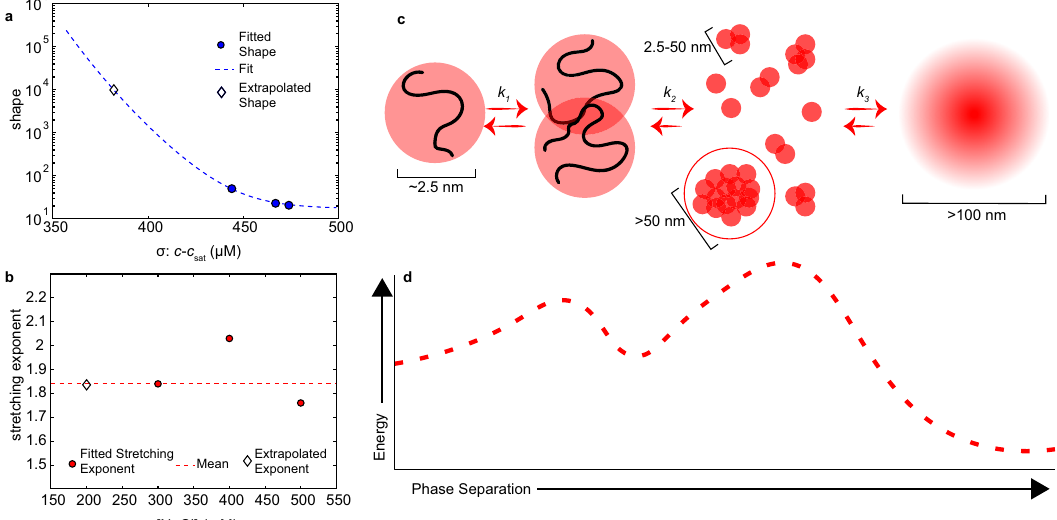
Fig. 9 Mesoscopic A1-LCD assembly is nucleated by an activated state. a The shape parameter de fi nes the Weibull distribution width, which is the timescale over which the transition occurs, and it depends on the degree of supersaturation ( σ ). Using the values from the fi ts in Fig. 7, the shape parameter for 200 mM NaCl can be extrapolated (diamond). b The stretching exponent varies minimally as a function of NaCl concentration. The average of all values from 300 to 500 mM NaCl is indicated with a red dashed line. Given the absence of a clear NaCl dependence the average value is used to calculate a PDF for 200 mM NaCl. c Schematic of phase separation of A1-LCD proceeding via three steps. 1. Low-af fi nity dimers form. 2. Monomers are added onto low-af fi nity small clusters to form a distribution of species as predicted by classical nucleation theory. 3. A large cluster grows with low probability beyond a critical size (circled in red) and the resulting nucleus grows. At each step, the approximate length scale is given based on the measurable scales in SAXS experiments. d The schematic in c is drawn as a phenomenological reaction coordinate based on the known barriers to dimer formation and phase